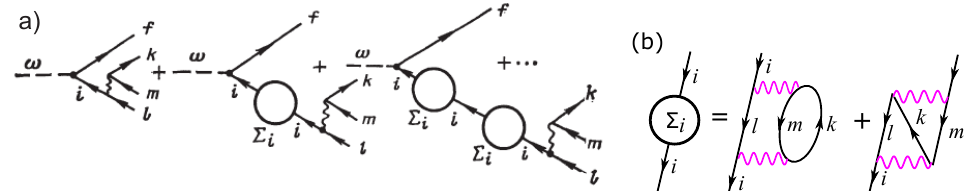
Figure 1. ( a ) Schematic representation of the SO process leading to a two-electron continuum. The circle represents the self-energy part of the SHGF expanded in more detail in ( b